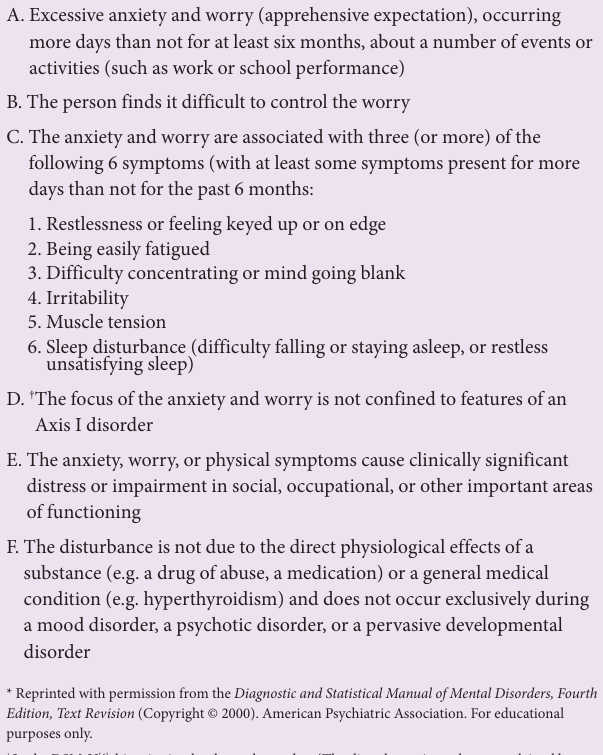
Table 1. Criteria for generalised anxiety disorder